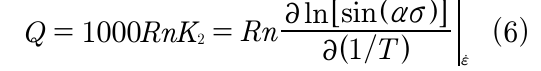
0.0052807 MPa -1 in dual-phase field and 0.0225252 MPa -1 in β - phase